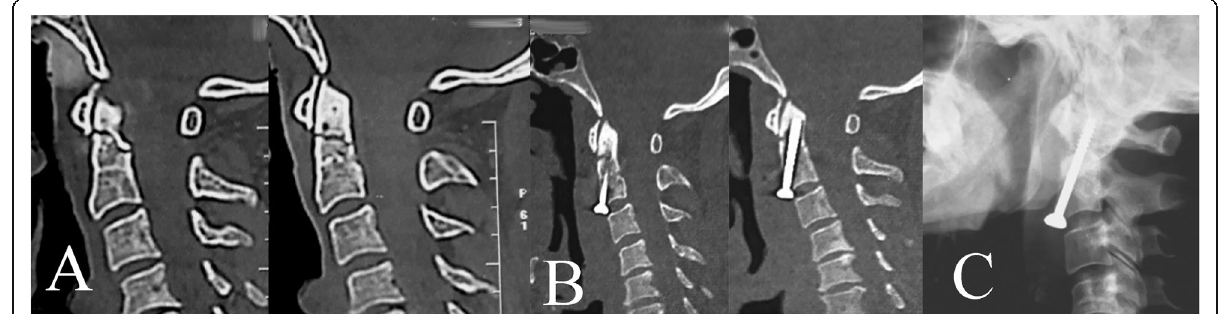
Fig. 2 a Preoperative sagittal CT cervical spine. b Post-operative sagittal CT cervical spine after 2 months. c Post-operative plain x-ray after 6